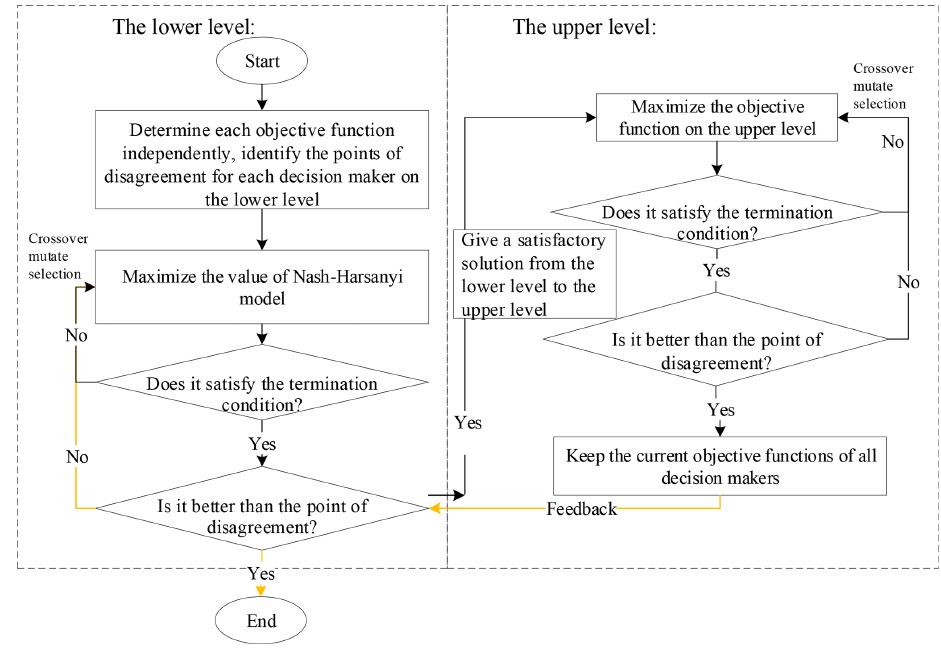
Figure 4. Steps for solving the proposed model.